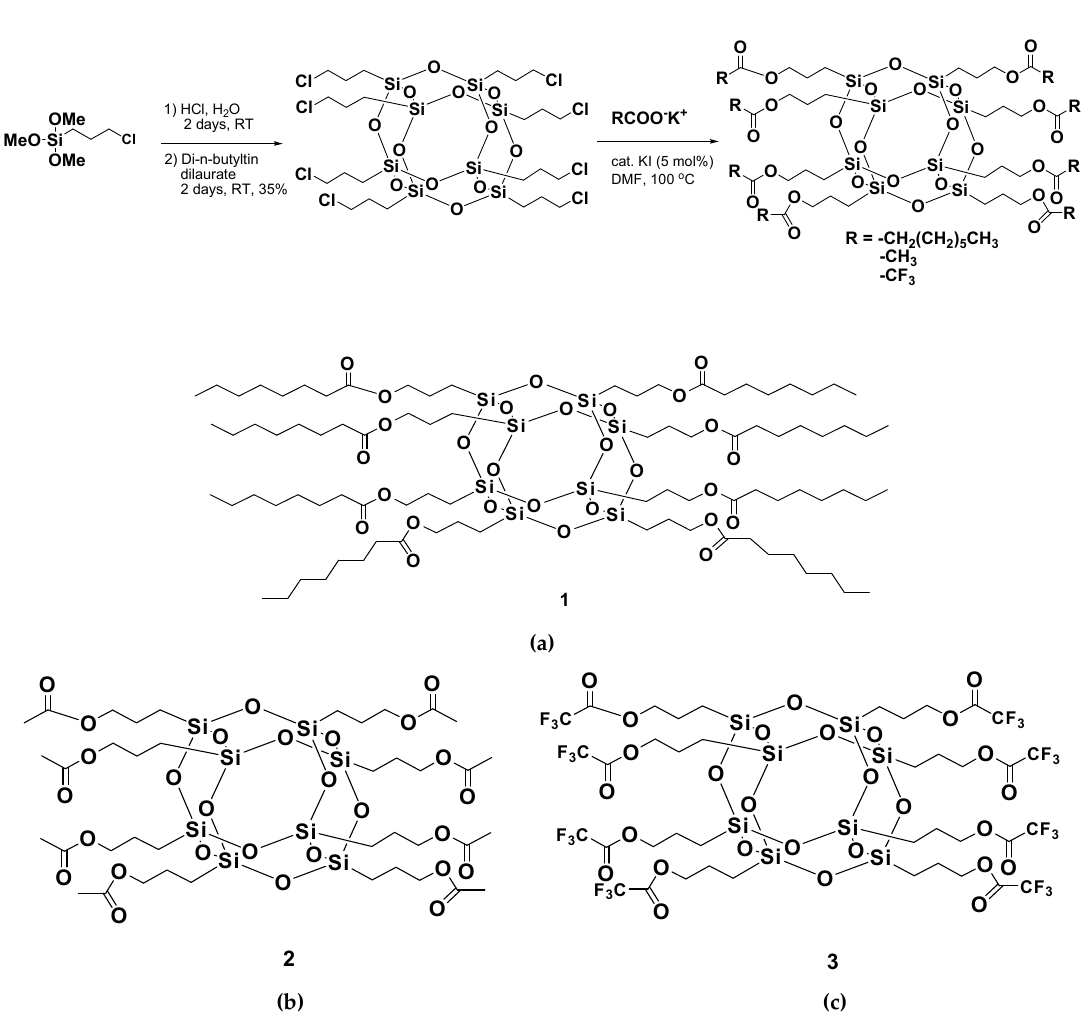
Figure 1. Structures of ( a ) POSS, ( b ) vegetable ester compound, and ( c ) octa-POSS-OH.